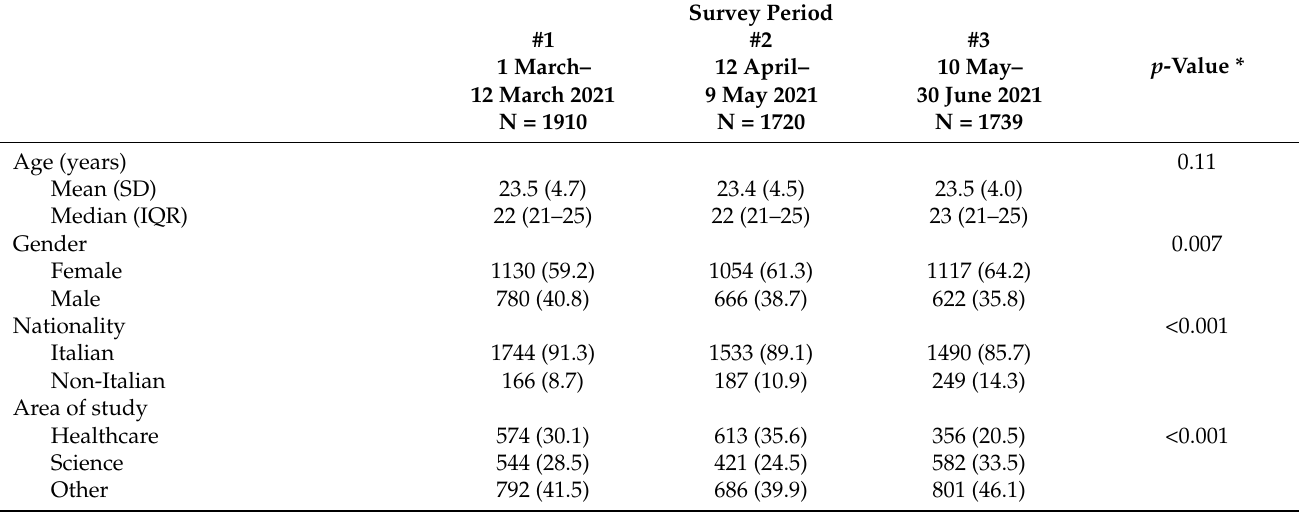
Table 1. Students’ sociodemographic characteristics by survey period. Results are expressed as mean (standard deviation, SD), median (interquartile range, IQR), or frequency (percentage). Survey